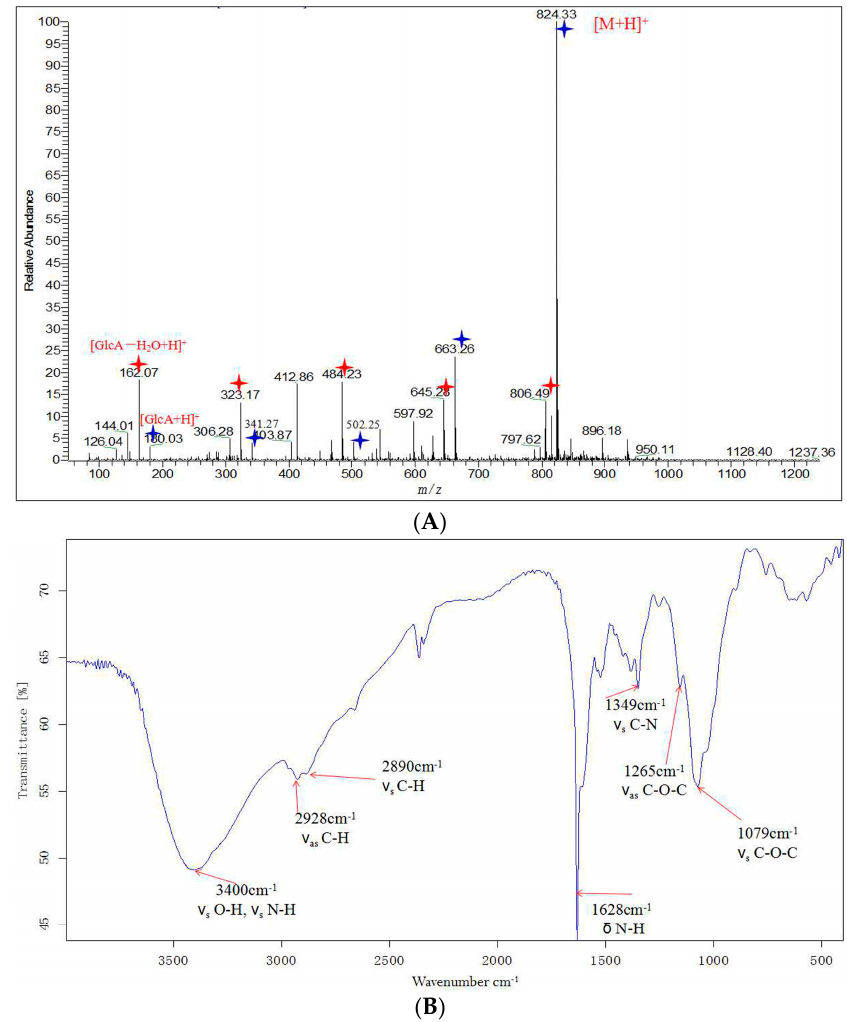
Figure 2. Positive ion electrospray ionization mass spectrometry (ESI-MS) spectrum ( A ); and Fourier transform infrared (FT-IR) spectrum ( B ) of oligochitosan DP5. The typical ion peaks for oligochitosan are indicated by blue and red star symbols in the ESI-MS spectrum. Blue stars represent the fragment ions 824.33, 663.26, 502.25 and 341.27 and 180.03 with one glucosamine residue decrease successively. Red stars represent the fragment ions 806.49, 645.28, 484.23, 323.17, and 162.07 with one glucosamine residue decrease successively. The important IR absorbances for oligochitosan are also shown in the FT-IR spectrum (red arrows).